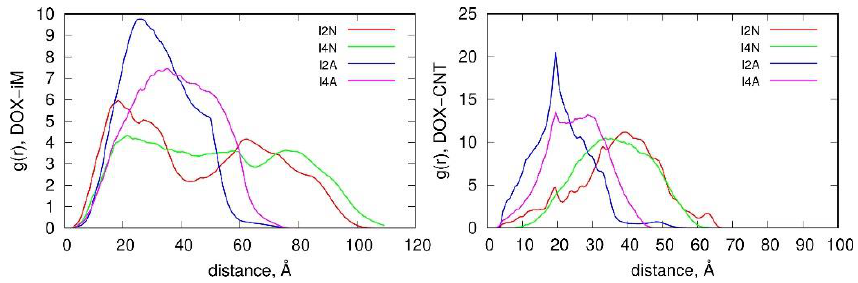
Figure 8. Radial distribution functions, g(r), between DOX center of mass and iM fragments (left panel) and between DOX center of mass and CNT (right panel).